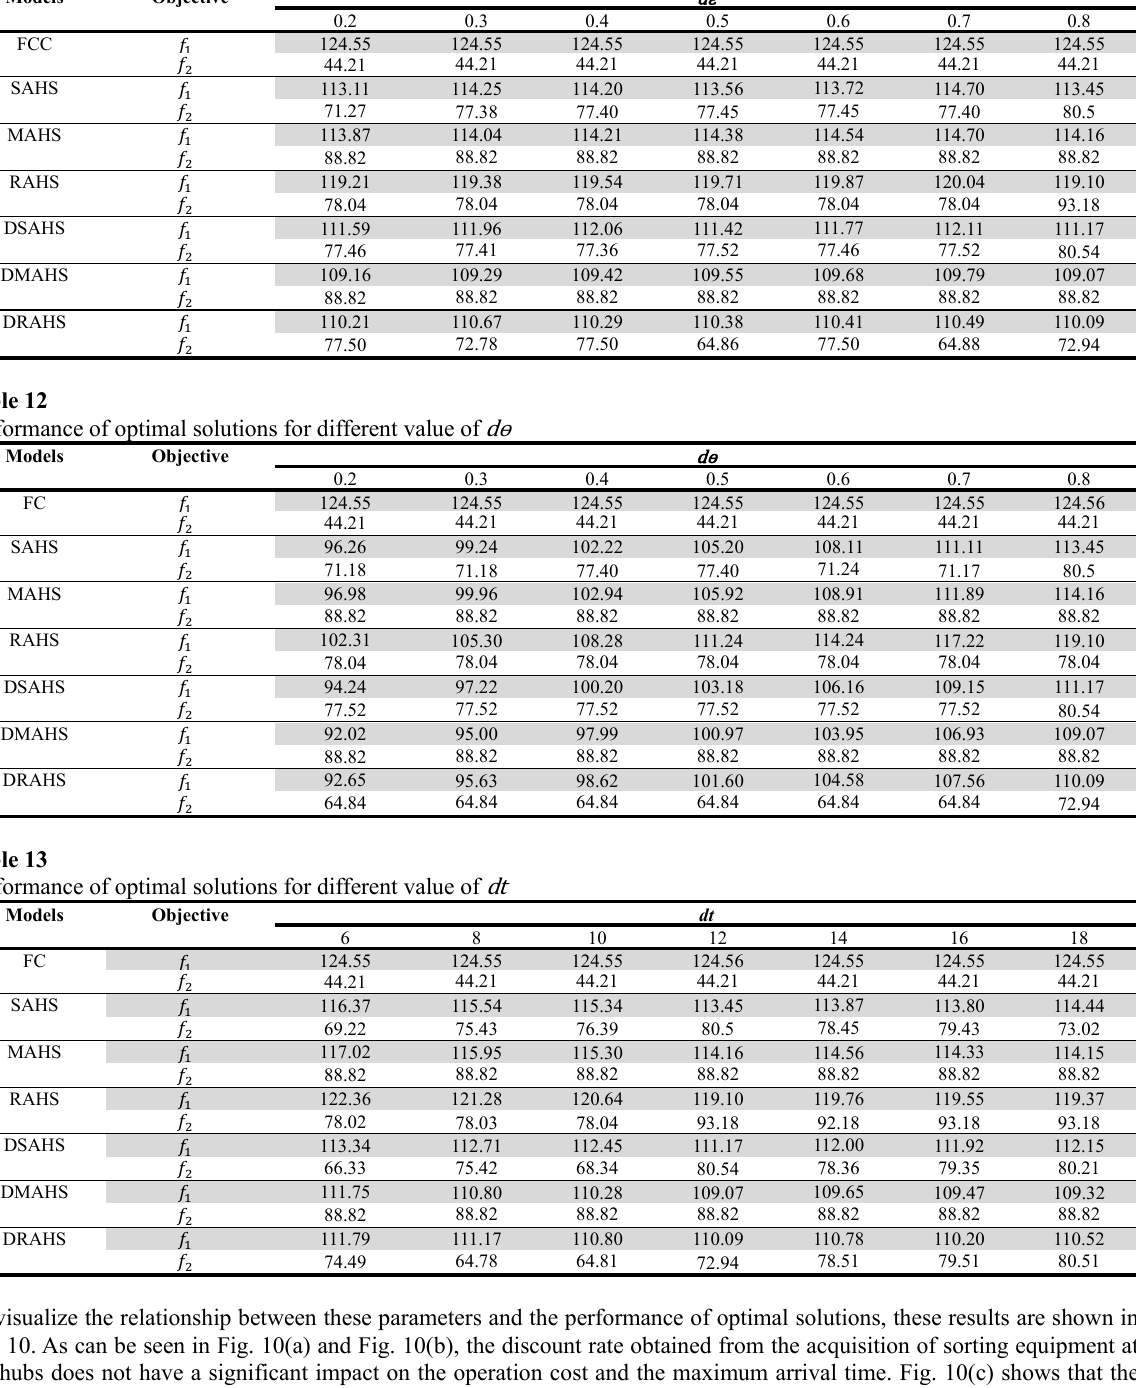
the hubs does not have a significant impact on the operation cost and the maximum arrival time. Fig. 10(c) shows that the higher the discount on parcel sorting costs is, the higher the operation cost is. By contrast, Fig. 10(d) indicates that changes in discount of parcel sorting cost have no noticeable effect on the maximum arrival time. On Figure 10, it can be seen that the longer the hold time of the parcel in the hub, their operation costs have a significant downward trend. However, when the hold time is increased by 12 hours, the operation costs do not have a significant downward trend. In Figure 10-f, we can find that the maximum arrival time increases with the increase in the hold time. In addition, the performance of the optimal solution obtained from the FC model is not affected by these